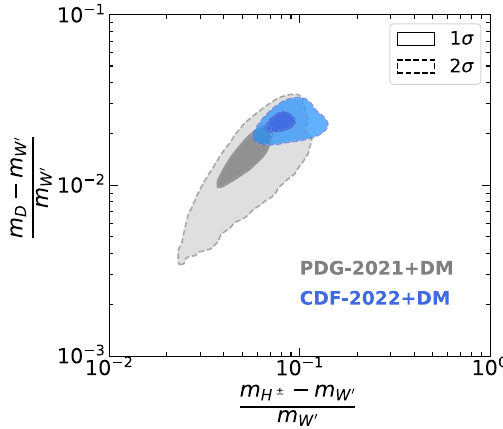
Fig. 8 The 1 σ (dark) and 2 σ (light) favored regions of the data from CDF-2022+DM (blue) and PDG-2021+DM (gray) projected on the plane of the mass splittings ( m H ± − m W (cid:3) )/ m W (cid:3) and ( m D − m W (cid:3) )/ m W (cid:3) for the heavy DM mass